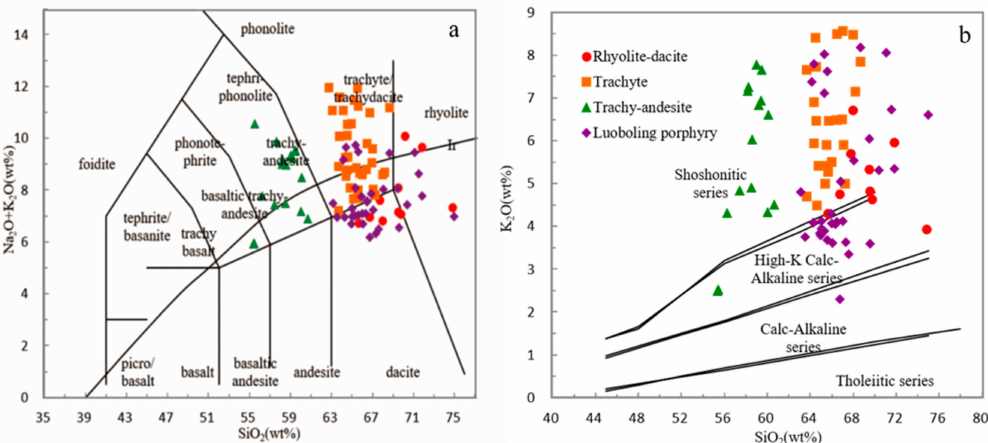
Figure 6. ( a ) Classification of volcanic rocks from the Shanghang Basin by plotting total alkali versus silica (TAS) diagram and ( b ) The whole rock K 2 O versus SiO 2 diagram. Data for the Luoboling porphyry are from